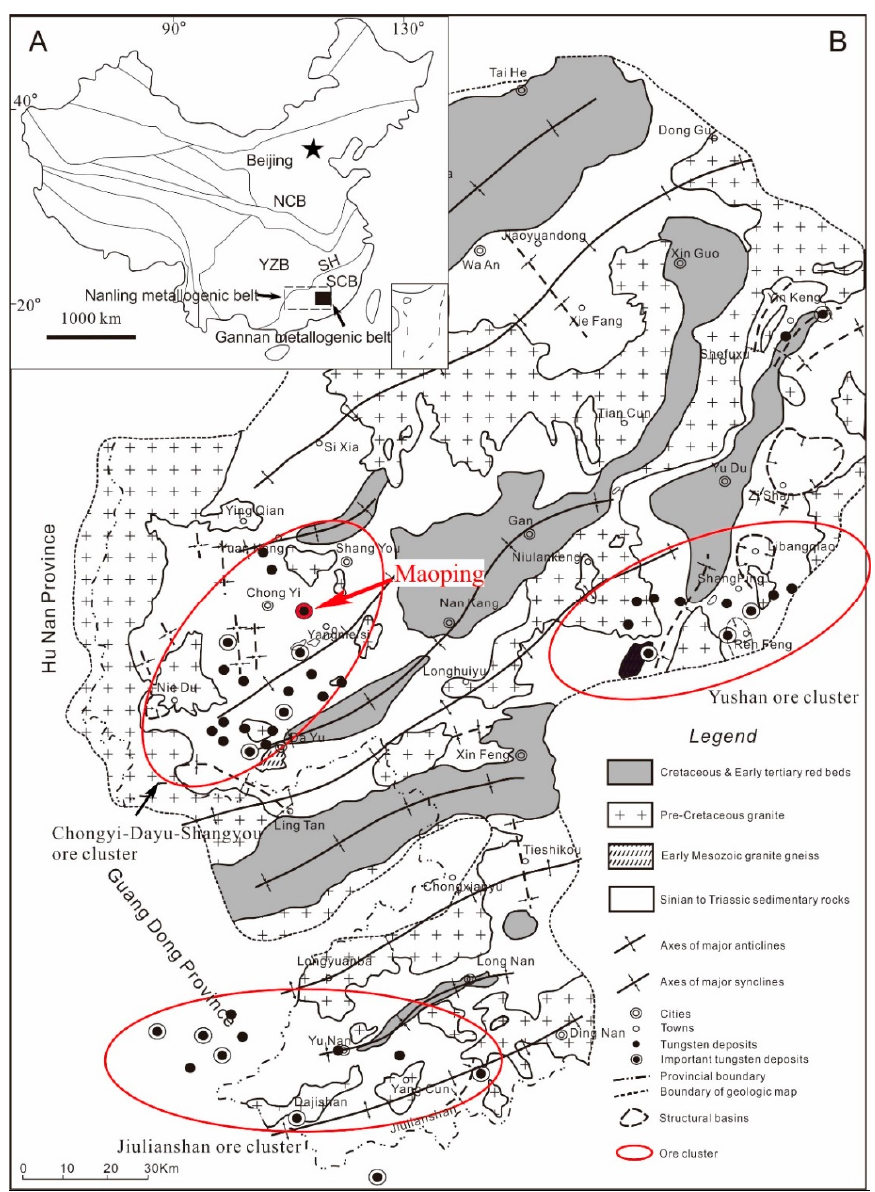
Figure 1. ( A ) A schematic tectonic map of China and the location of the Gannan metallogenic belt and the Nanling metallogenic belt; ( B ) the geology and distribution of the ore deposits in the Gannan metallogenic belt and the location of the Maoping tungsten deposit (modified from